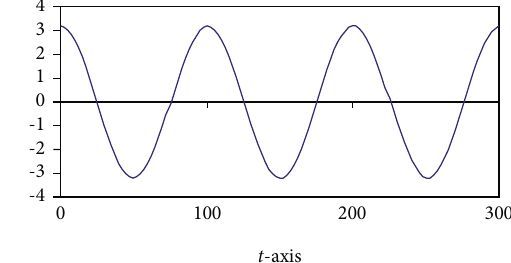
Figure 2: The analytical solution J against the time t